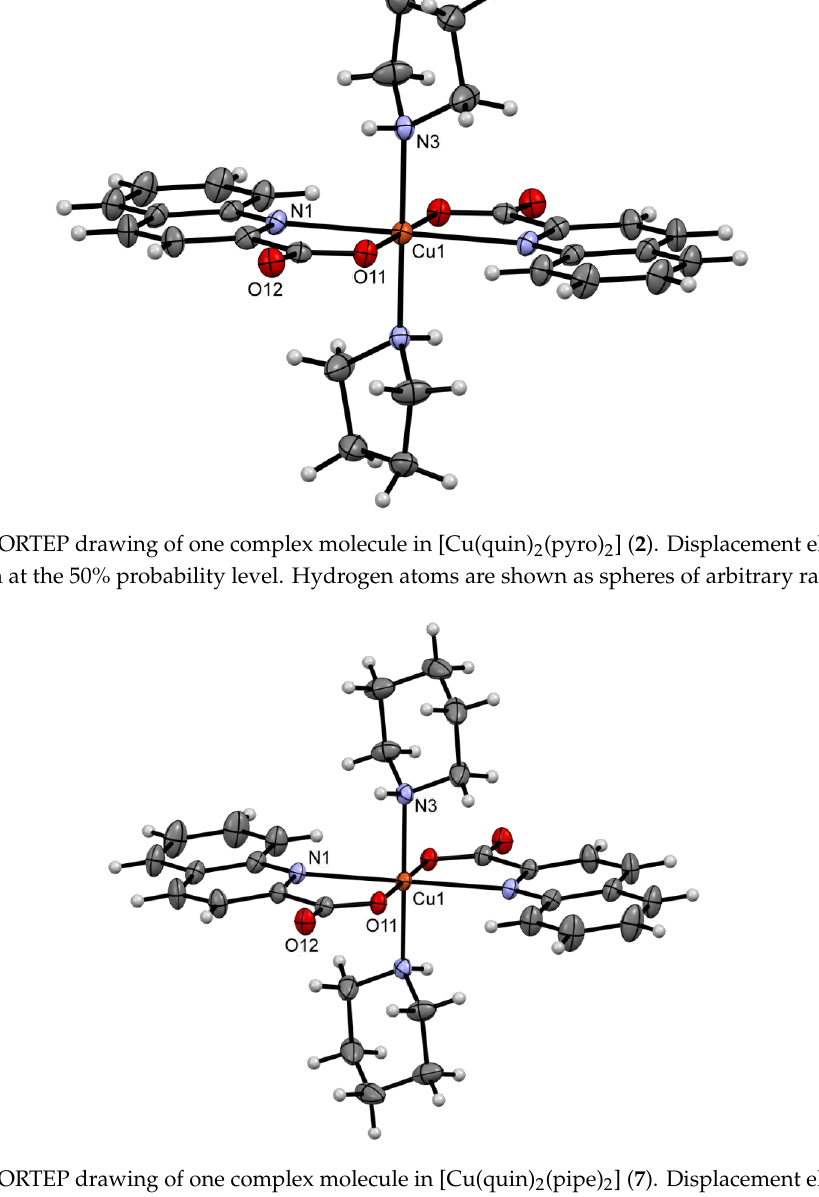
Figure 4. ORTEP drawing of one complex molecule in [Cu(quin) 2 (pipe) 2 ] ( 7 ). Displacement ellipsoids are drawn at the 50% probability level. Hydrogen atoms are shown as spheres of arbitrary radii.